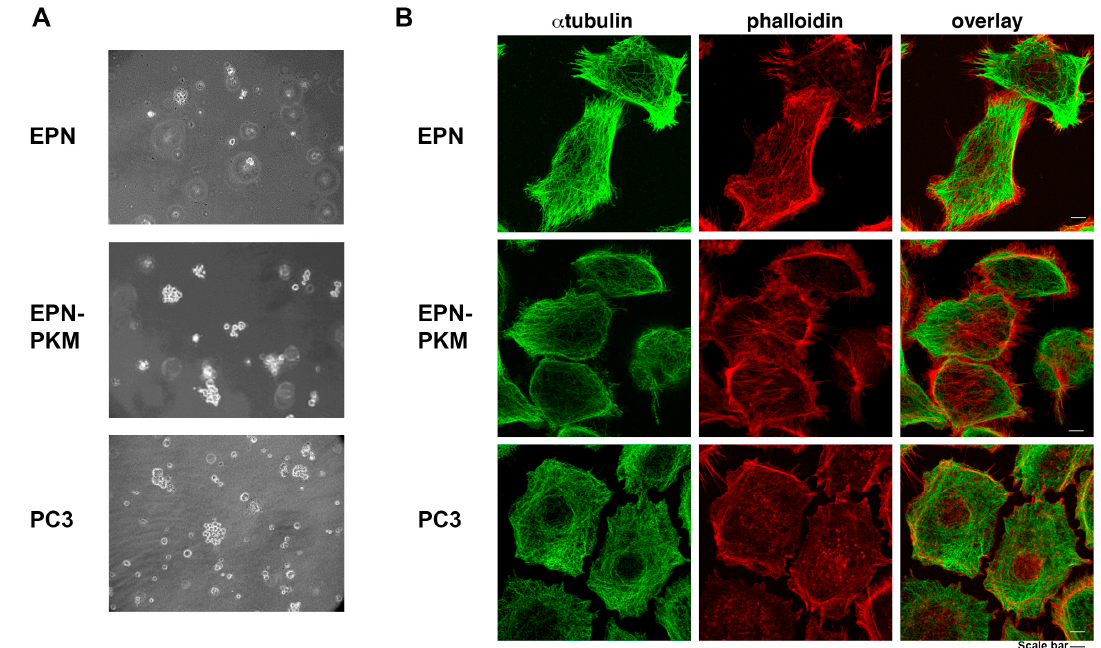
Figure 1. Growth in semi-solid medium and cytoskeleton organization of EPN, EPN-PKM and PC3 cells: ( A ) Growth of EPN, EPN-PKM and PC3 cells in semi-solid medium. EPN, EPN-PKM and PC3 cells single cell suspensions were seeded in agar-containing medium, observed daily and photographed after 15 days. Cells have been observed with Axiovert 25 (Carl Zeiss, Jena, Germany) and photographed with Canon GC5 (Canon Italia S.p.A, 20063 Cernusco sul Naviglio, Milan, Italy) (final magnification 40×). PC3 cells were used as positive controls; ( B ) Microtubule and Actin cytoskeleton morphology in EPN, EPN-PKM and PC3 cells. Cells were stained for double-immunofluorescence with a monoclonal antibody against α -tubulin revealed with a FITC-conjugated secondary antibody ( green ) and with TRITC-phalloidin ( red ). Bars, 5 μ m.